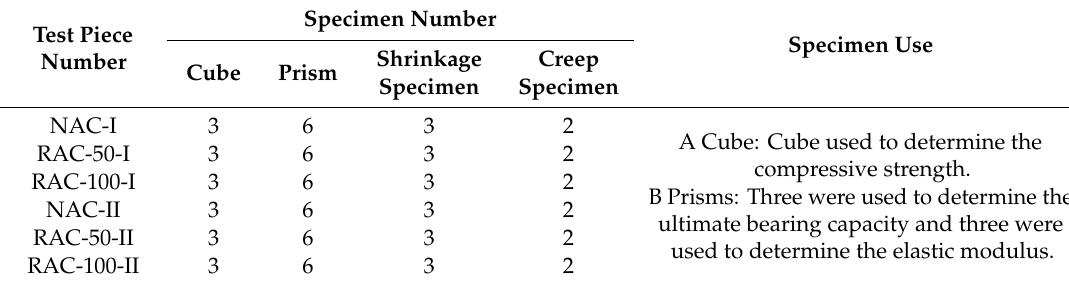
Table 3. Number and use of